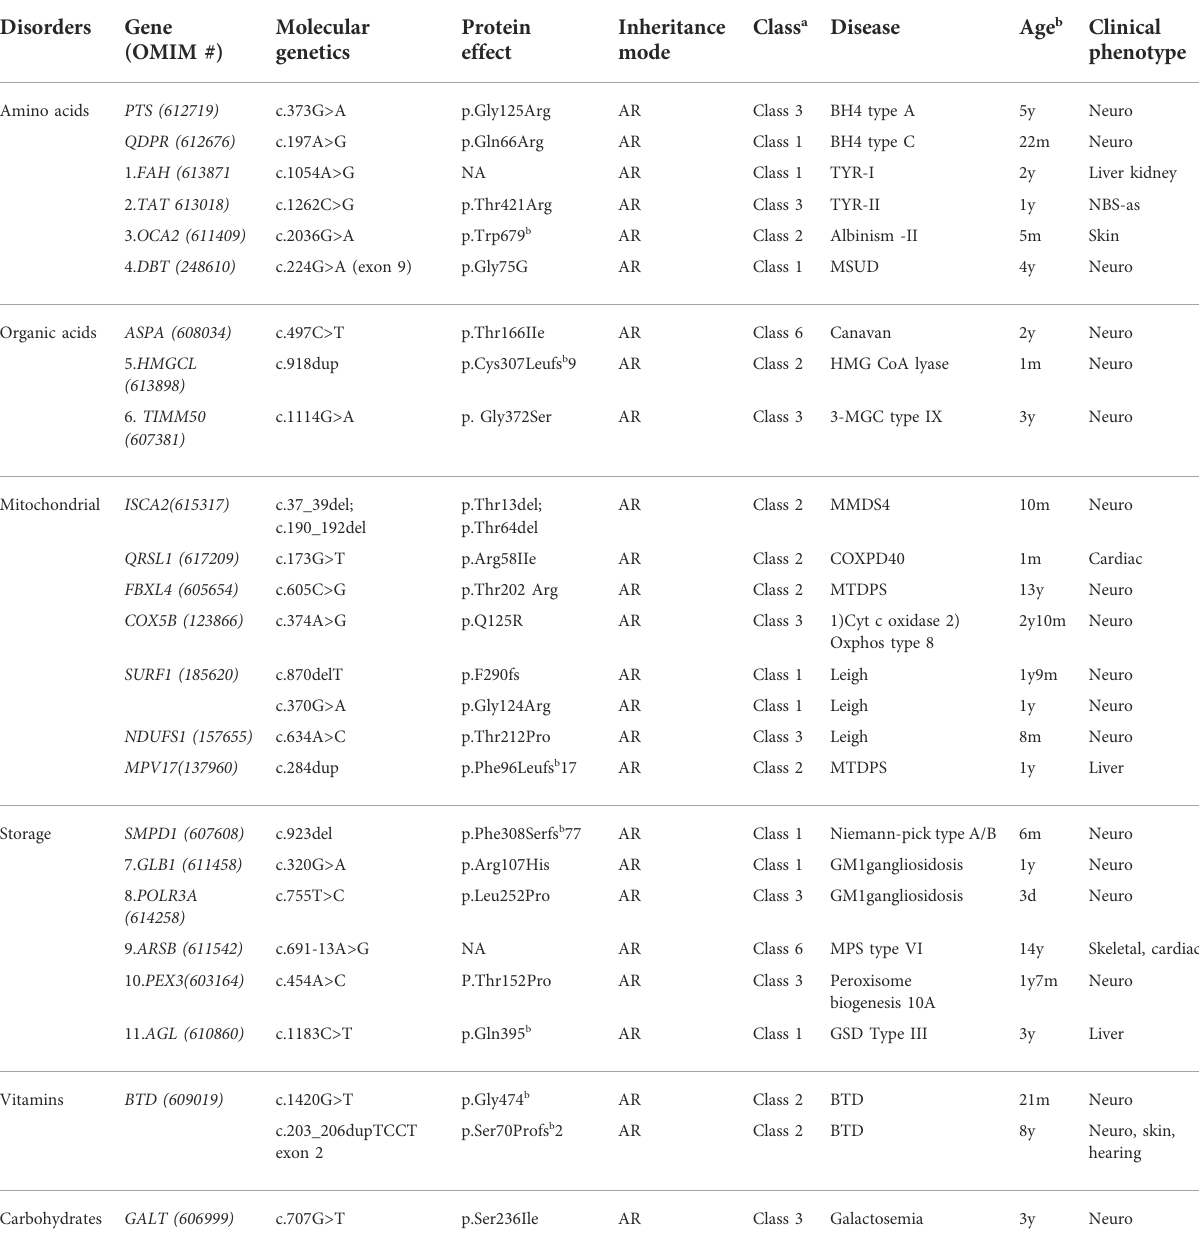
TABLE 2 Novel mutations detected in 31 patients clinically and biochemically suspected of